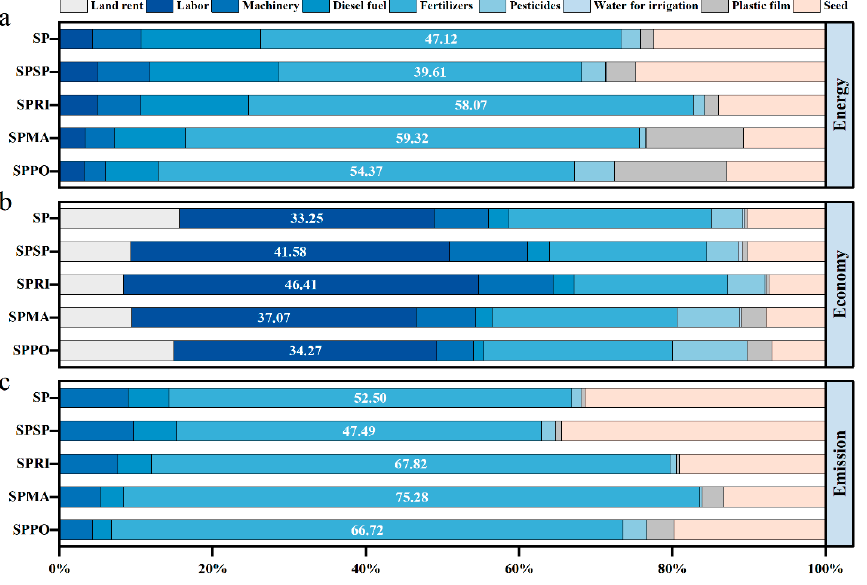
Figure 5. Energy inputs of nitrogen (N), phosphorus (P 2 O 5 ), potassium (K 2 O), and farmyard manure of mono cropping of sweet potato (SP); continuous cropping of sweet potato (SPSP); and rotation cropping system of sweet potato–rice (SPRI), sweet potato–maize (SPMA), and sweet potato–potato